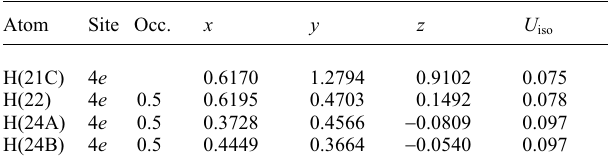
Table 3. Atomic coordinates and displacement parameters (in Å 2 )